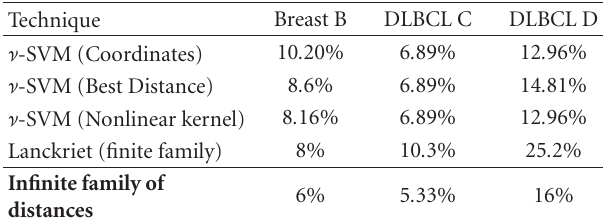
Table 3: Accuracy for the ν -SVM using a linear combination of non-Euclidean dissimilarities in an HRKHS. The ν -SVM based on the best distance, the classical ν -SVM, and the Lanckriet formalism have been taken as a